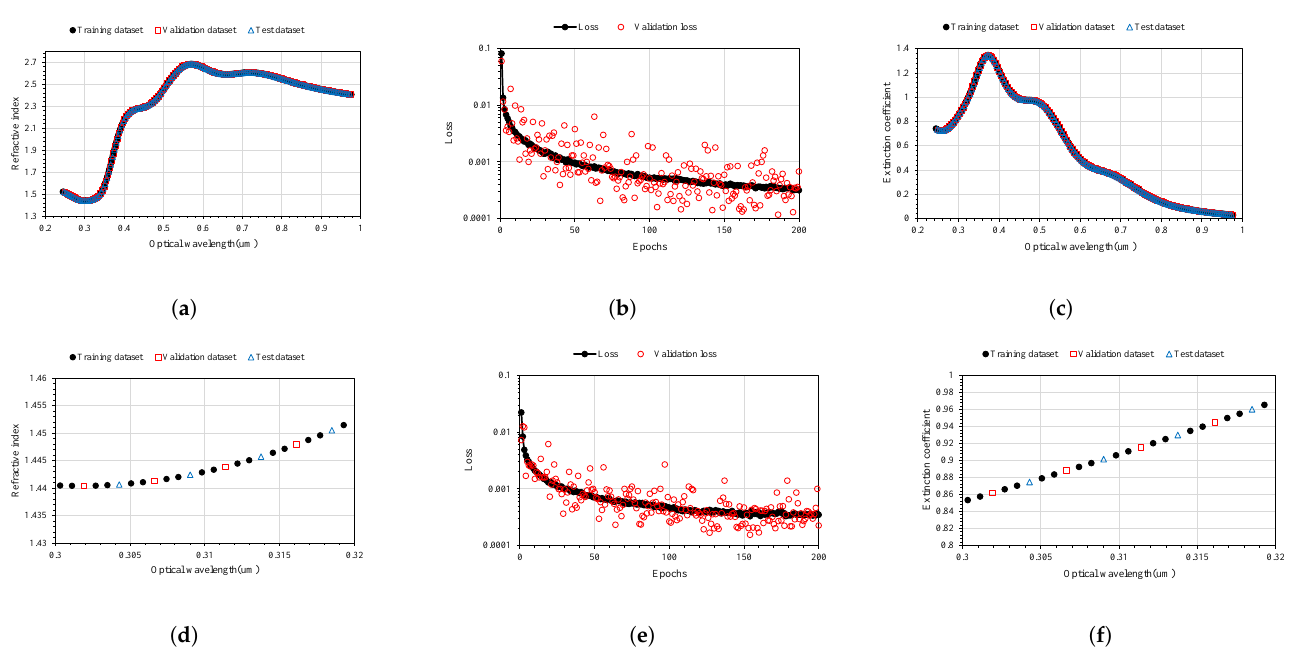
Figure 3. AI training, validation, and test data sets of measured optical properties on FAPbI 3 and learning loss progress with epochs: ( a ) whole refractive index data set of FAPbI 3 , ( b ) AI learning progress on refractive index of quaternary perovskite with loss and validation loss, ( c ) whole extinc- tion coefficient data set of FAPbI 3 , ( d ) extension refractive index data set of FAPbI 3 , ( e ) AI learning progress on extinction coefficient of quaternary perovskite with loss and validation loss, ( f ) extension extinction coefficient data set of FAPbI 3